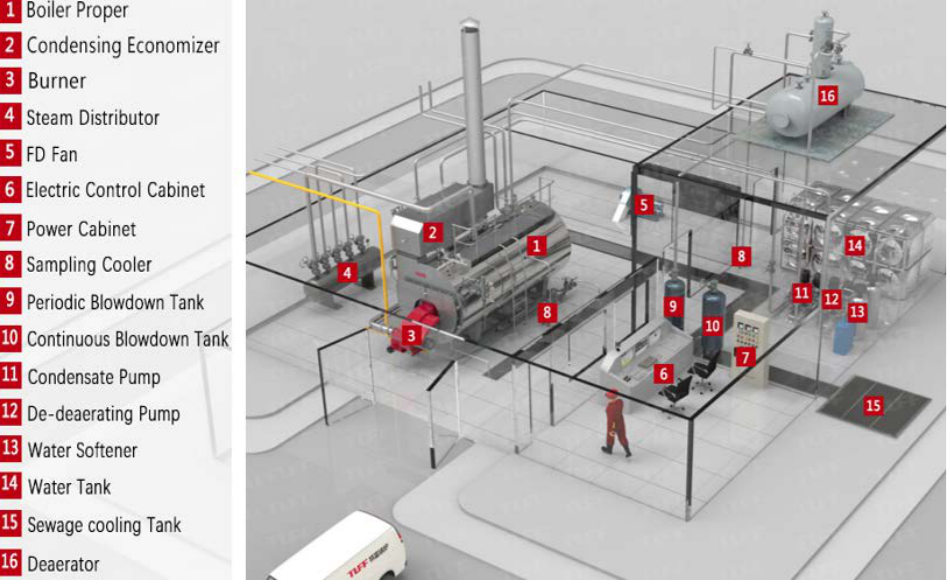
Figure 1: General overview of steam boiler (Watt,